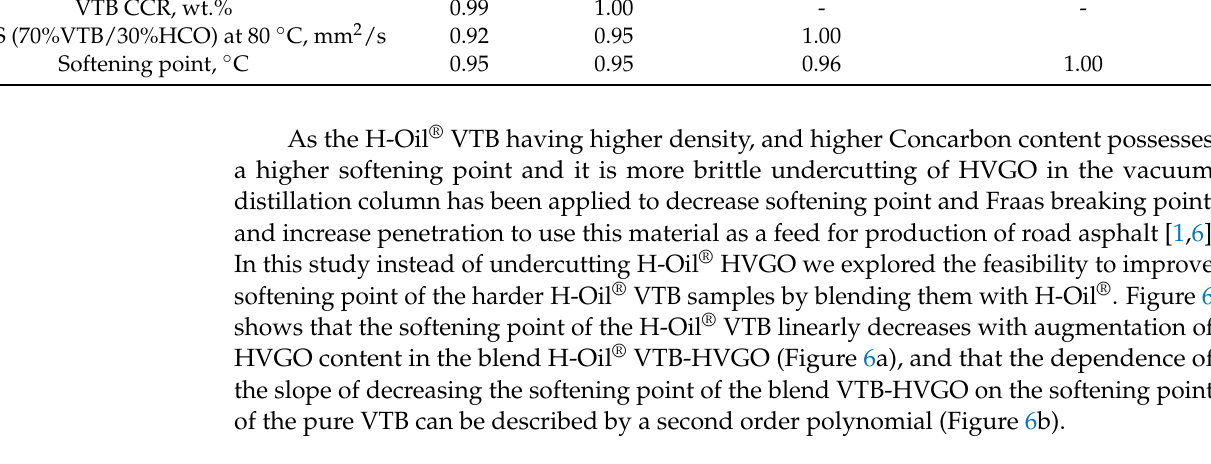
Figure 5. Dependence of density ( a ), viscosity ( b ), and softening point ( c ) of H-Oil ® VTB on Concarbon content. Table 4. 1 μ-value of ICrA for the evaluation of relations of H-Oil ® VTB properties density, Concarbon content (CCR),